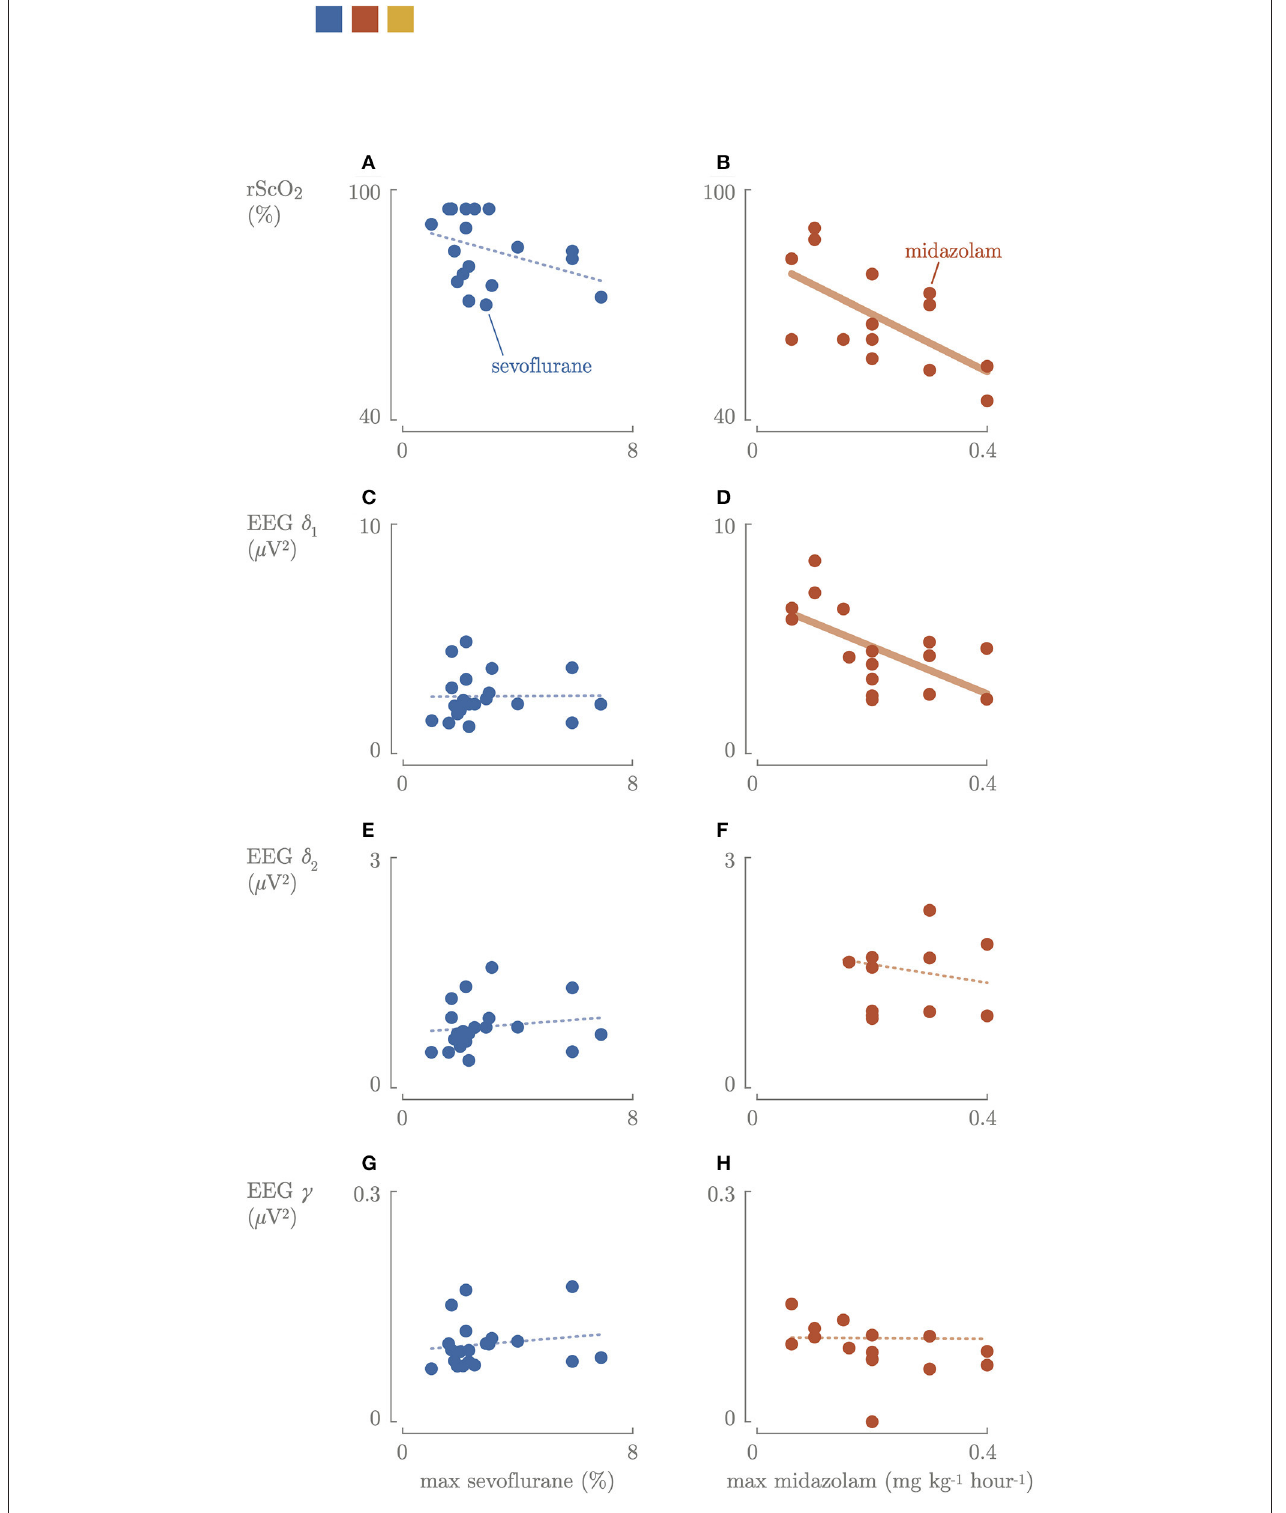
FIGURE 3 | Correlation between the maximum sevoflurane concentration or maximum dosages of midazolam cerebral oxygenation (A,B) and cerebral activity: slow delta (C,D) , fast delta (E,F) , gamma (G,H) power. Blue, sevoflurane group; red, midazolam group; fat line, significant correlation.